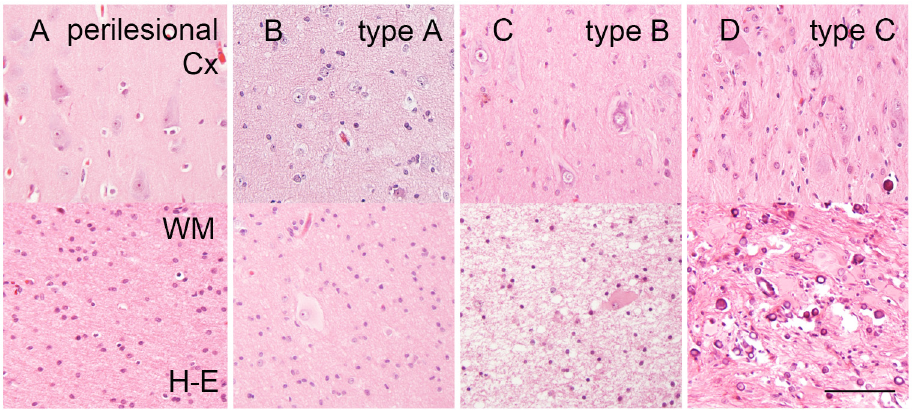
Fig 1. Histology of tuber variants. A. Perilesional cortex (Cx) and white matter (WM) of an 8-year old male patient. B. Type A tuber (Cx and WM) in a 5-year old female patient with a tuber in the frontal lobe. C. Type B tuber (Cx and WM) located in the parietal lobe of an 8-year old boy (same as in Fig 1A). D. Type C tuber of a 2-year old male patient located in the frontal lobe. Scale bar in D = 100 μ m and applies also to A , B and C